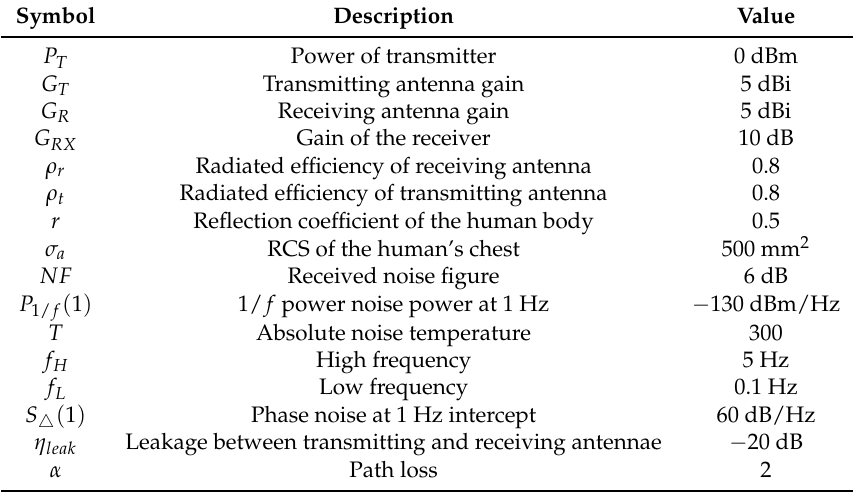
Table 1. System parameters used for simulation.